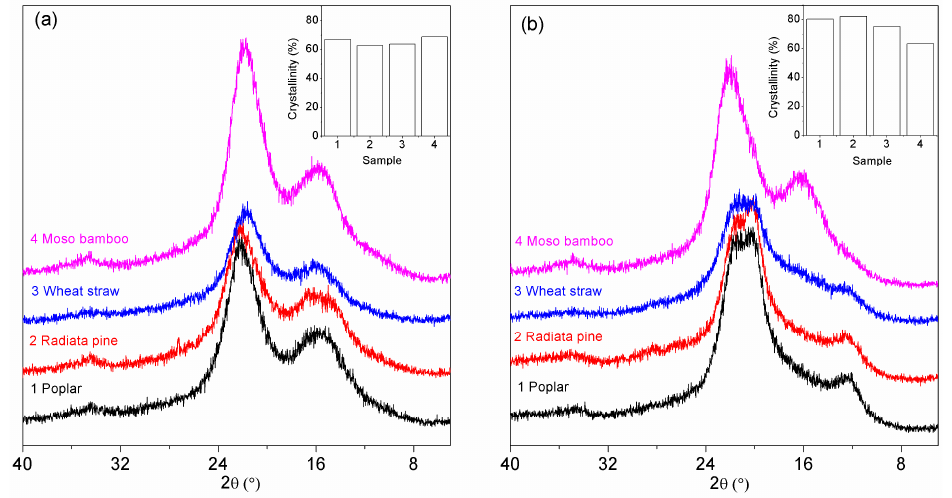
Figure 2. X-Ray Diffraction (XRD) patterns of ( a ) biomass particles and ( b ) celluloses that were extracted from particles.